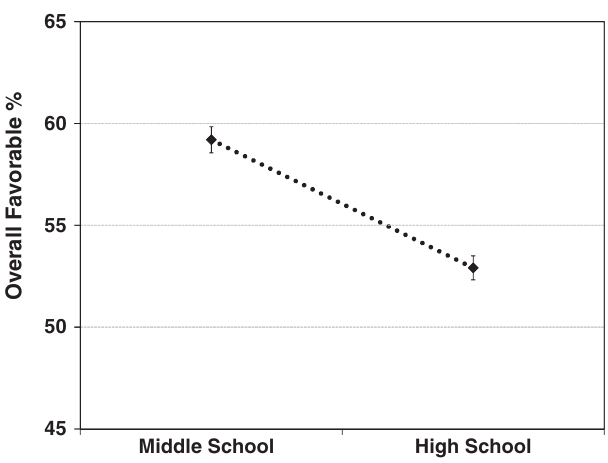
FIG. 1 (color online). Overall favorable percentages on CLASS for middle and high school students. Error bars indicate standard